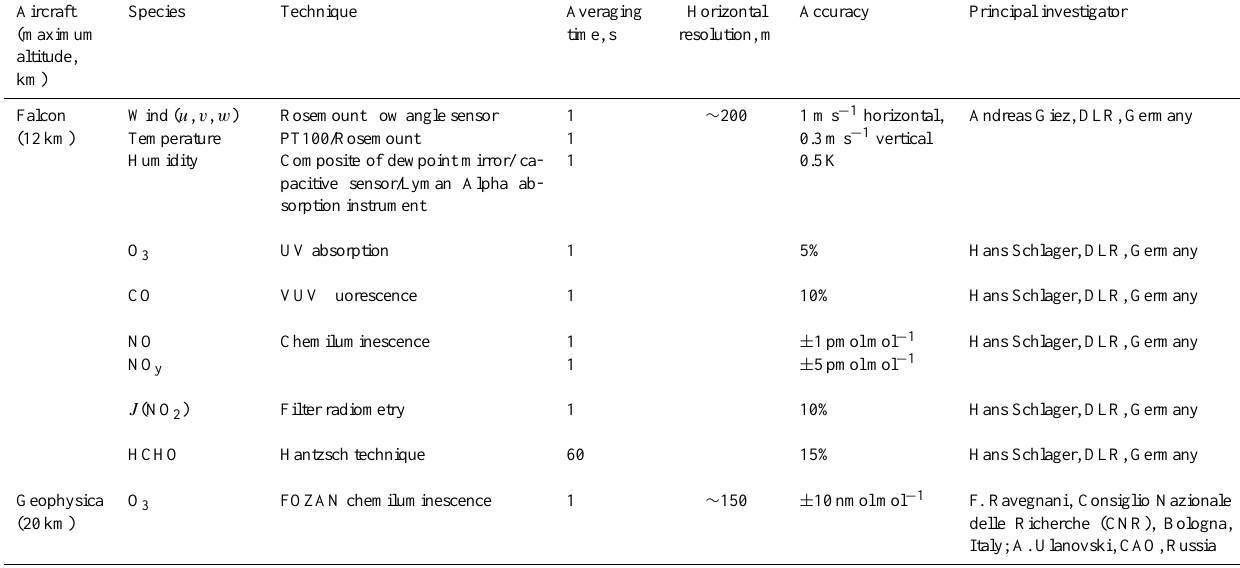
time, s resolution, m ∼ 1 1 1